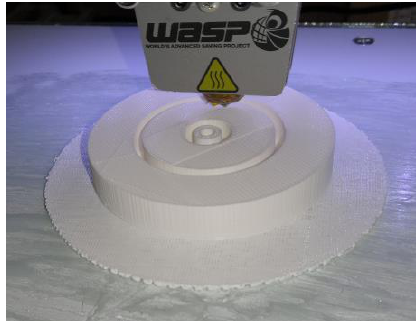
Figure 13. Three-dimensional (3D)-printed tag prototype during the realization phase.